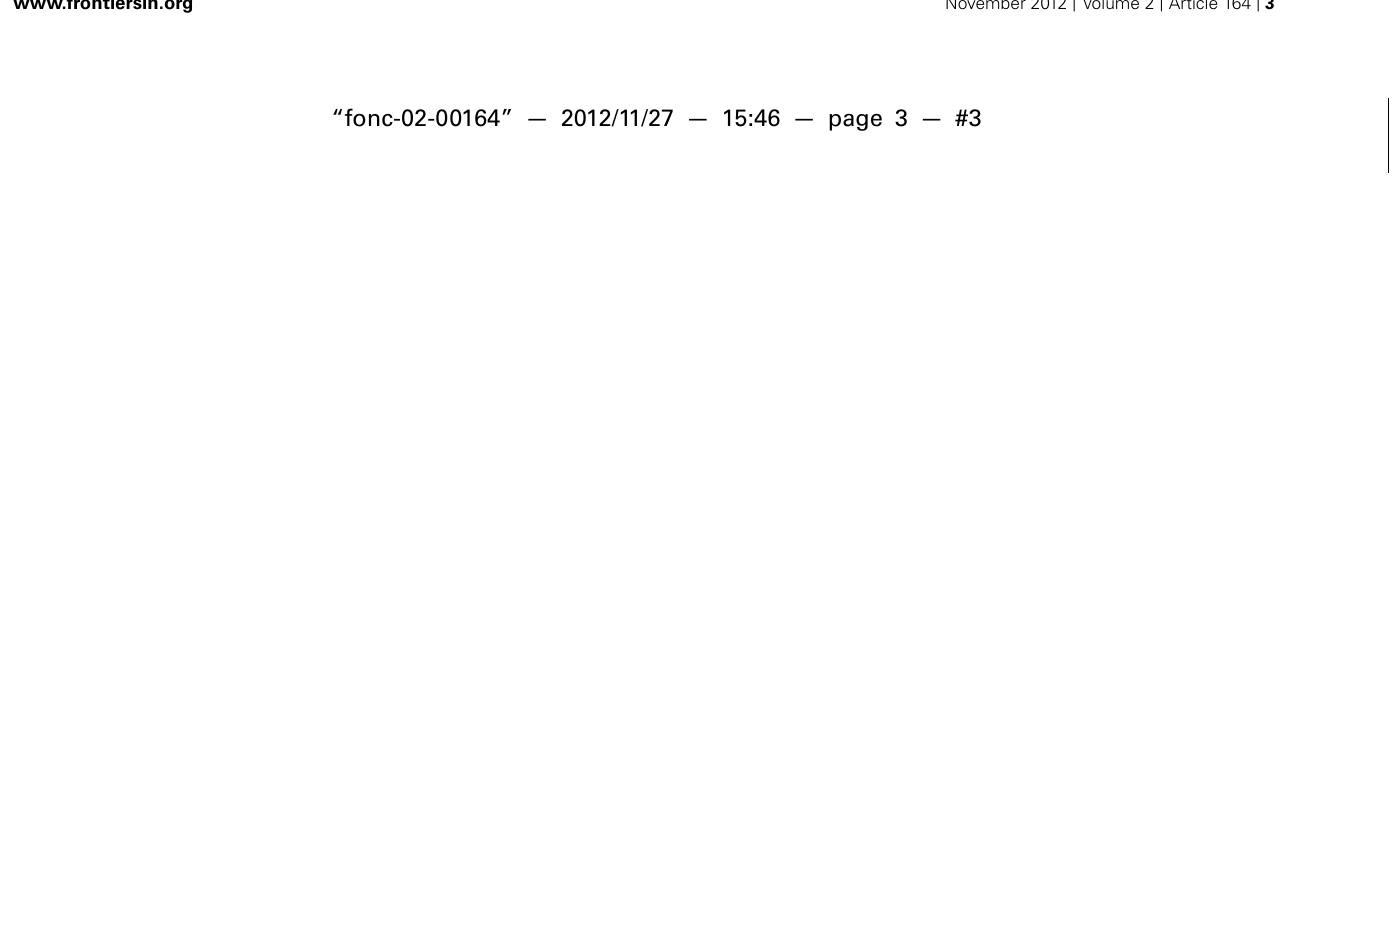
FIGURE 1 | Schematic representation ofVDAC1 as a multi-functional channel and convergence point for a variety of cell survival and cell death signals. The various functions ofVDAC1 include control of the metabolic cross-talk between the mitochondria and the rest of the cell, cellular energy homeostasis by transporting ATP/ADP and NADH between the inter-membrane space and the cytosol and by binding HK, signaling by transporting Ca 2 + , ROS release to the cytosol and apoptosis, both by binding to the apoptosis regulatory proteins, Bcl-2 family and HK. Also presented are the Ca 2 + influx and efflux transport systems in the outer and inner mitochondrial membranes and Ca 2 + -mediated regulation of the tricarboxylic acid (TCA) cycle.The activation of pyruvate dehydrogenase